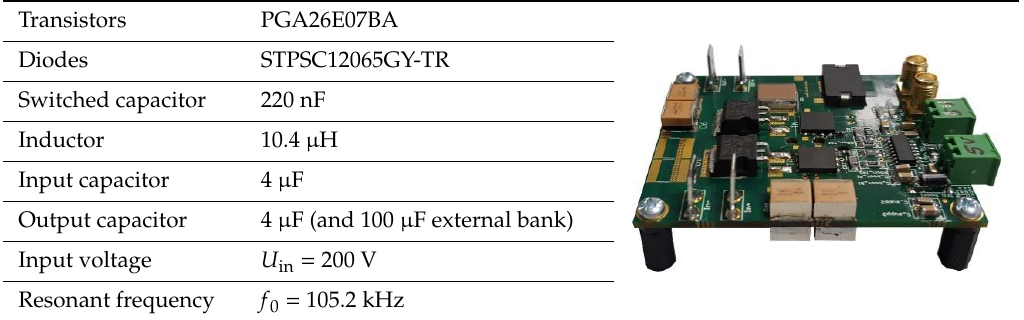
Table 4. Parameters of the laboratory test setup.